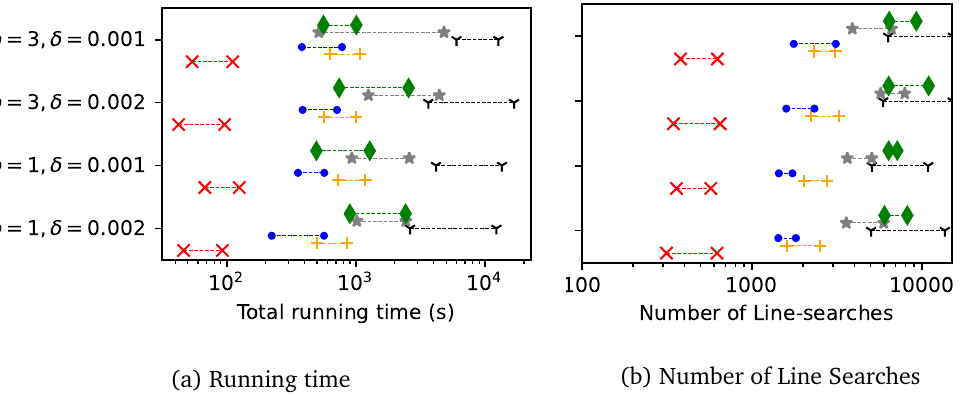
Figure 7: Number of line searches and total running time for estimating the target polytopes in the different scenarios. Colors and symbols indicate the same scenarios as Figure